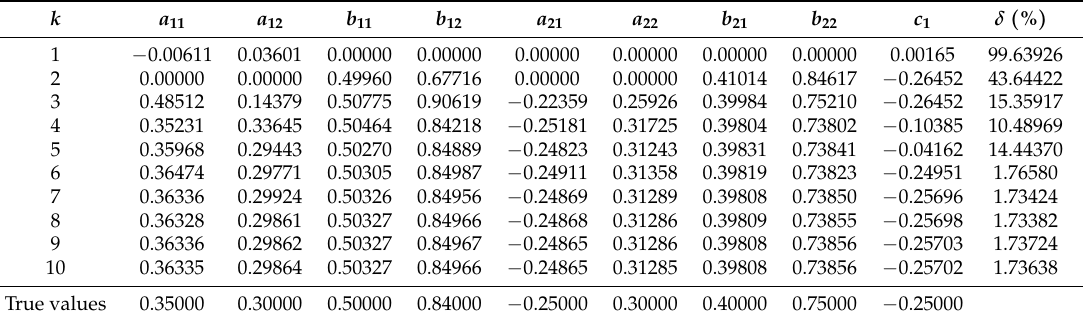
Table 6. The F-LSI parameter estimates and errors for Example